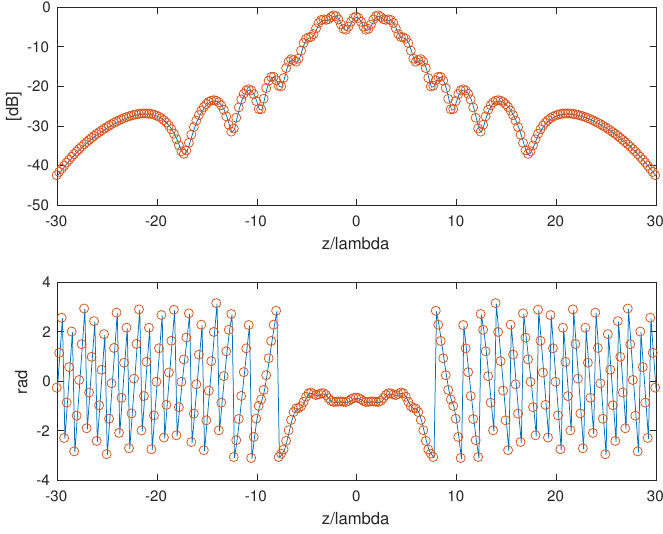
Figure 6. Near field amplitude ( top ) and phase ( bottom ) along the observation line; the sampling points using standard λ /2 spatial sampling step are plotted as